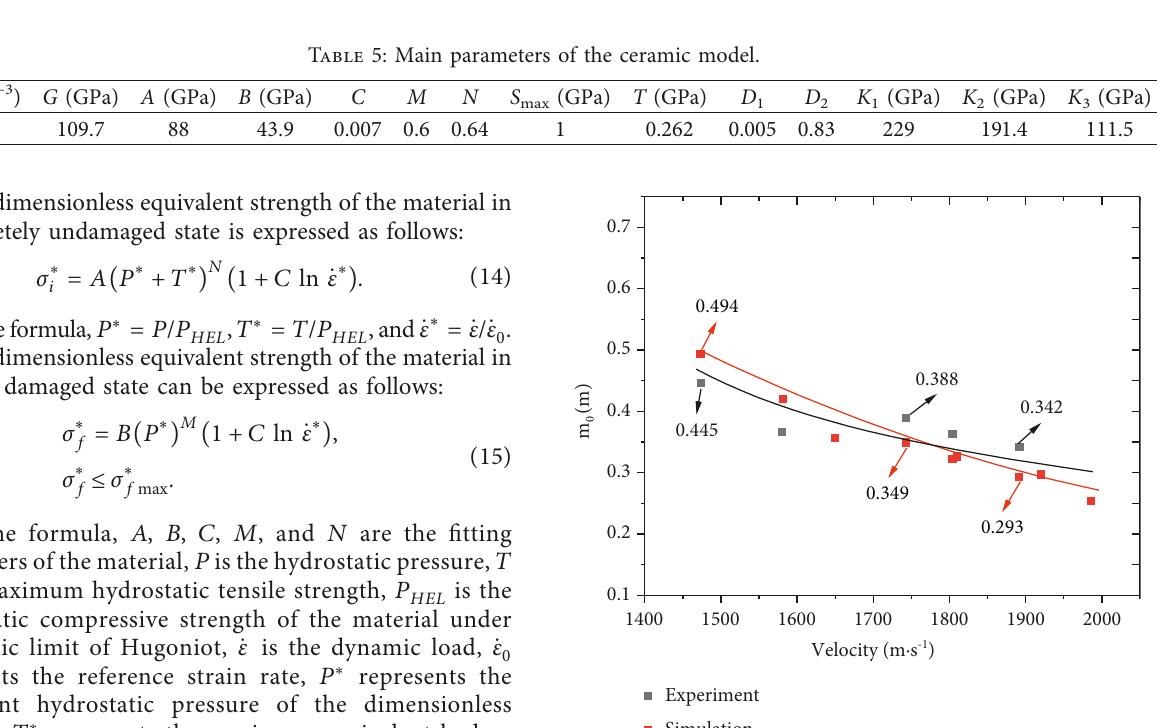
4.3. Numerical Simulation Verification. Figure 9 shows that the simulated value and experimental value of the projectile mass under different penetration speeds were basically the same. Both show a linear downward trend, and the error of the mass ratio was within 5%, demonstrating the accuracy of the numerical simulation. The mass loss of the projectile gradually decreased upon increasing the impact velocity, and there was no major inflection point. It also proved that the mass loss did not occur because of the velocity reversal phenomenon caused by the penetration of the C-RPC target. Figure 10 is a comparison diagram of the simulated value of the penetration depth of the projectile and the experimental value. The simulated speed of the projectile was the upper critical inflection point at 1743 m/s, which is in good agreement with the experimental value. The lower critical inflection point velocity was 1810 m/s, which is consistent with the experimental value of 1804 m/s. Because of the influence of the nonuniformity of the target, the penetration depth fluctuates with the increase of the projectile impact velocity. In the simulation process, the mean square error (MSE) of penetration depth is 4.95%, which demonstrates the accuracy of the numerical simulation.